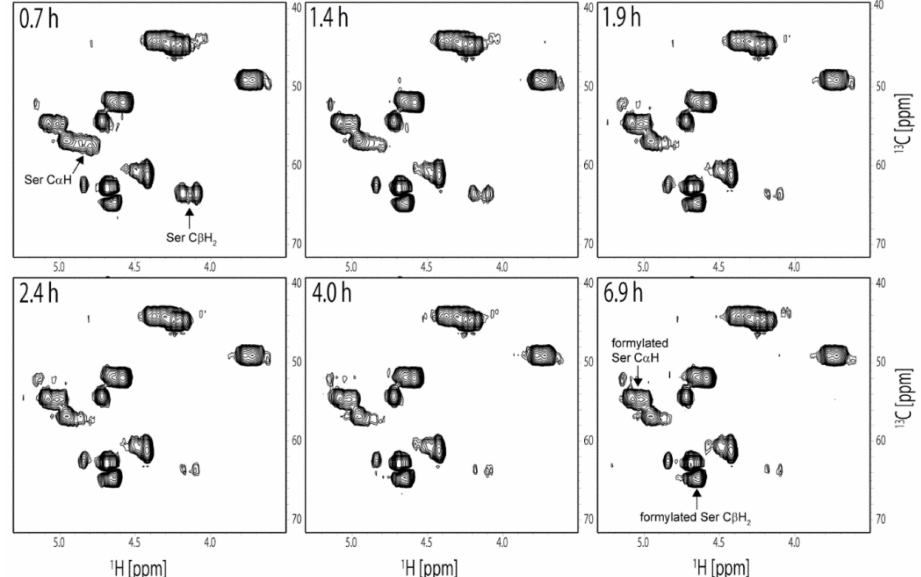
Figure 3. 13 C HSQC spectra of RSSP(VLI) measured several times continuously to observe the formy‑ lation in real time after the dissolution of RSSP(VLI) in FA. The elapsed time from start of the mea‑ surements is denoted in the top left of each box. Peaks derived from unformylated and formylated Ser residues are denoted in the